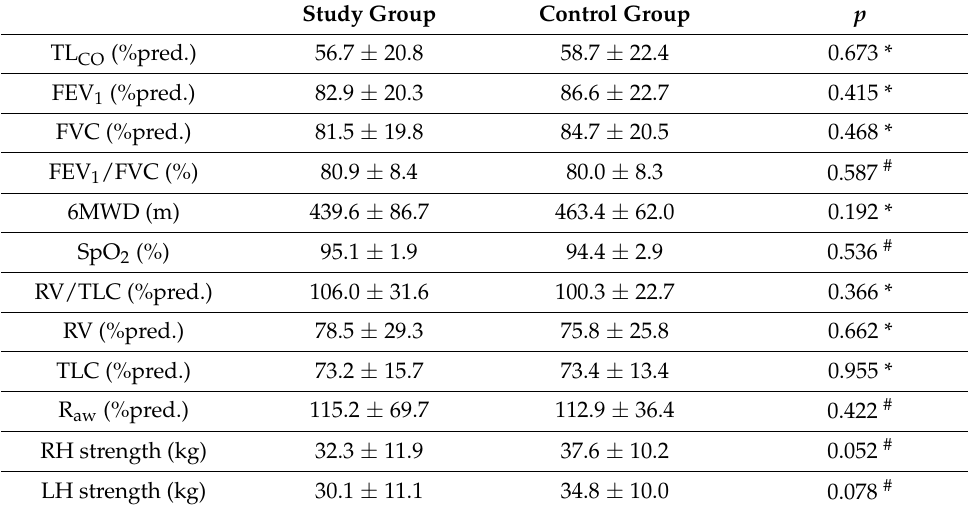
Figure 1. Study recruitment protocol. ILD, interstitial lung disease; IIP, idiopathic interstitial pneu- monia; 6MWT, 6-minute walk test; PR, pulmonary rehabilitation. Table 2. Lung function and exercise test results at baseline. Table 1. Study demographics. Study